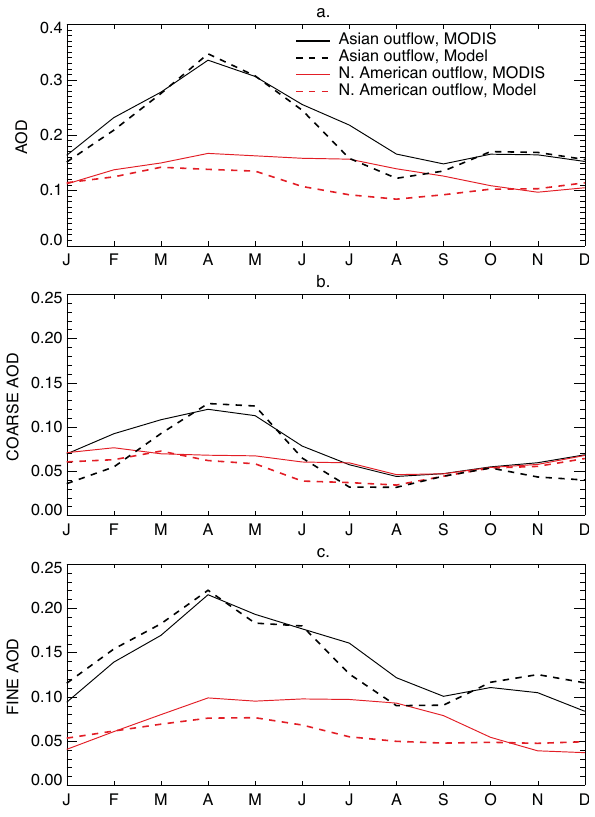
Fig. 7. Seasonal evolution of MODIS (solid lines) and GEOS-Chem (dotted lines) 550nm AOD in the E. Asian and N. American outflow regions in the NW Pacific Ocean (145 ◦ –155 ◦ E, 30 ◦ –50 ◦ N, black) and NW Atlantic Ocean (65 ◦ –55 ◦ W, 30 ◦ –50 ◦ N) for 2004-2010. Individual panels show the total AOD (a) , coarse mode AOD (b) and fine mode AOD (c)